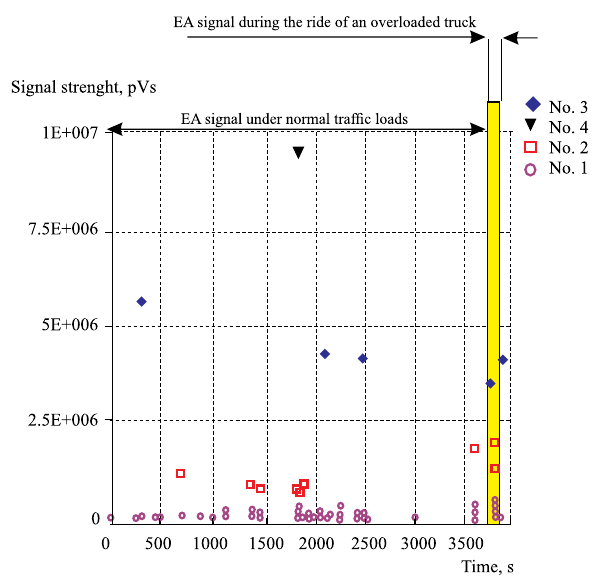
Fig. 9. Examples of the AE signals measured in Zone 6